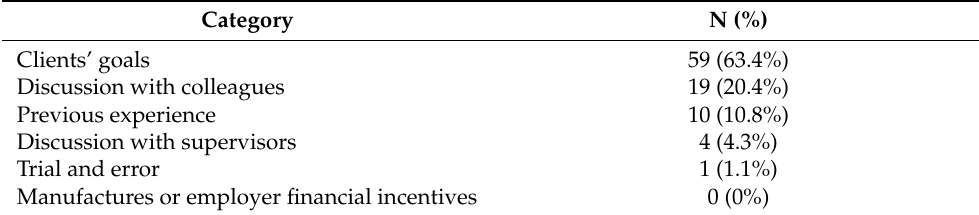
Table 2. Categorization for the question “What type of information would use in a scenario where the optimal solution is not clear or there is conflicting information or contraindication for the patients’ auditory rehabilitation?”.